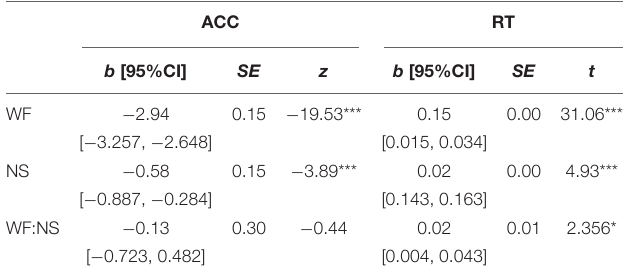
TABLE 3 | The results of GLMM/LMM models of neighborhood size and word